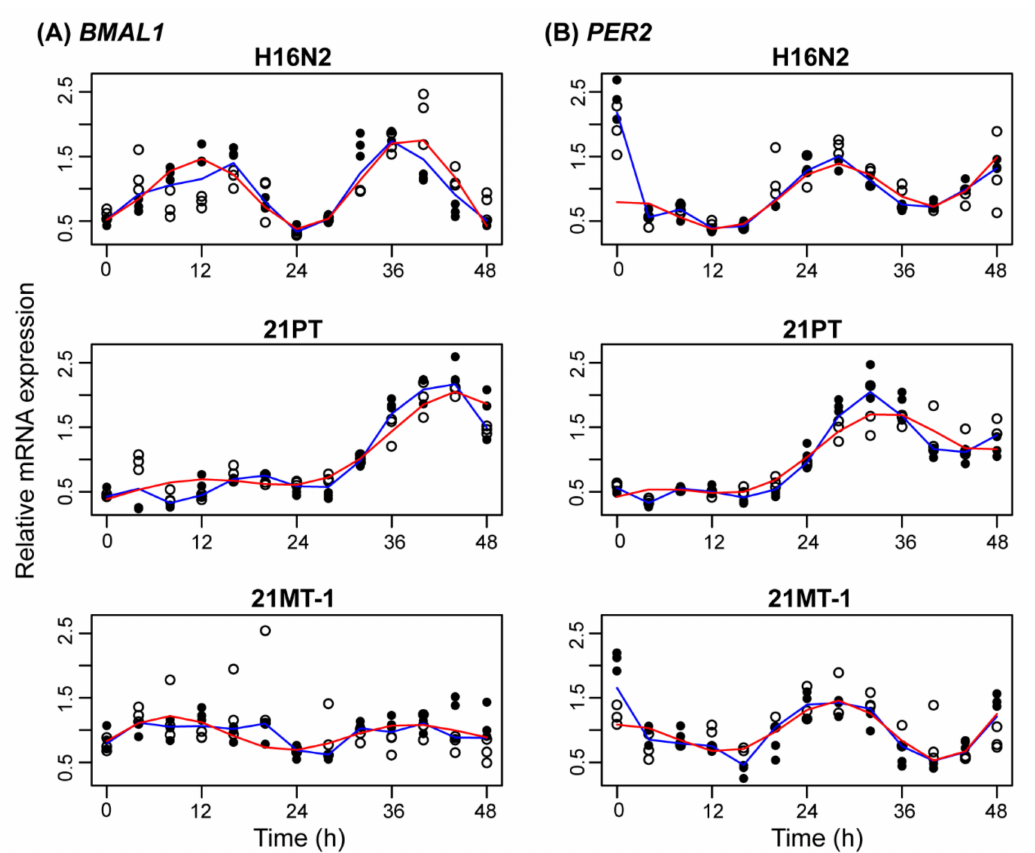
Figure 1. Relative mRNA expression of ( A ) BMAL1 and ( B ) PER2 across the 21T series of cells. Shown are the mRNA expression levels relative to the mean over time for each biological replicate (sample number (n) was 6 for all but 4 time points in 21MT-1, where n = 5). The experiment was conducted twice (n = 3 for each); open and closed circles are used